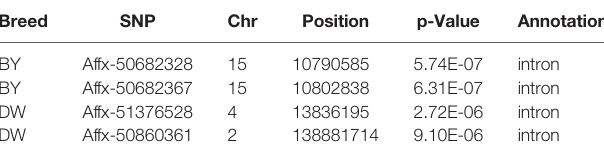
TABLE 3 | List of signi fi cant SNPs of genome-wide association studies. Breed SNP Chr Position p-Value Annotation BY